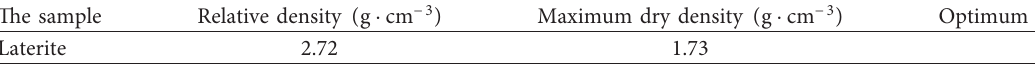
Table 2: Main physical parameters of